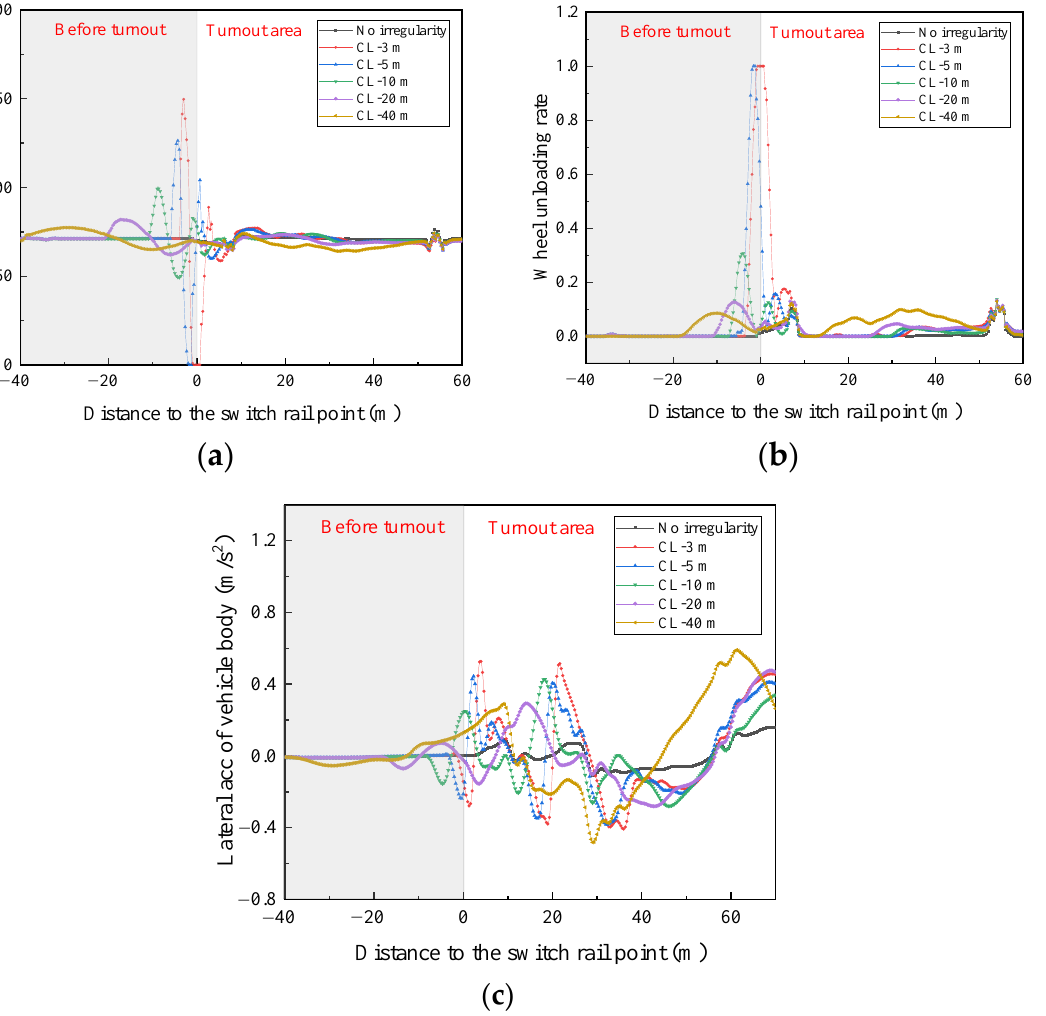
Figure 16. Variations along the distance in the dynamic indicators under the CL in front of the turnout: ( a ) Wheel-rail vertical force; ( b ) wheel unloading rate; ( c ) Lateral acceleration of the vehicle body. Figure 17 shows the time-frequency diagrams of the wheel-rail vertical force, wheel unloading rate, and lateral acceleration of the vehicle body under the CL in front of the turnout at wavelengths of 3 m and 40 m. Similar to the influence of the LL, the CL at the wavelength of 3 m has a significant effect on wheel-rail vertical force and wheel unloading rate. Under the CL at the wavelength of 3 m in front of the turnout, the high-frequency response of the wheel-rail vertical force appears at the extreme value. The frequency range of its influence on wheel unloading rate is below 50 Hz. The CL at the wavelength of 40 m has a more obvious influence on the lateral acceleration of the vehicle body, and its main influence frequency range is less than 5